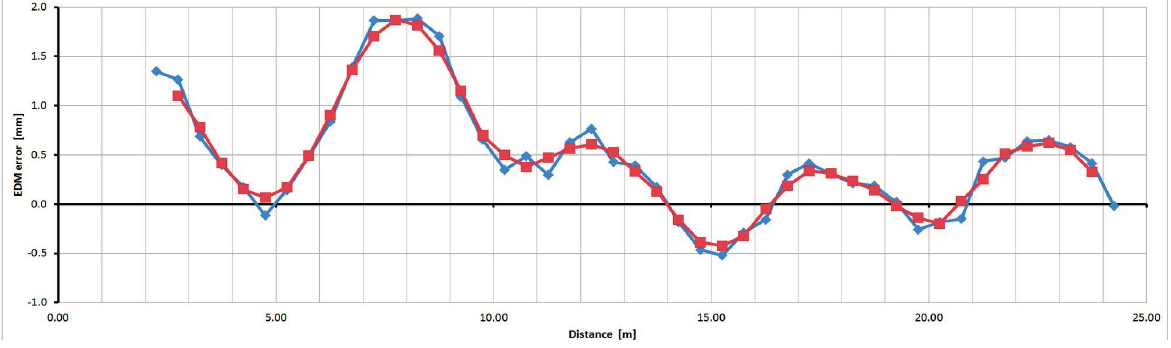
Figure 30. Relative errors of the Topcon GPT-7501 instrument (measured blue, averaged red).